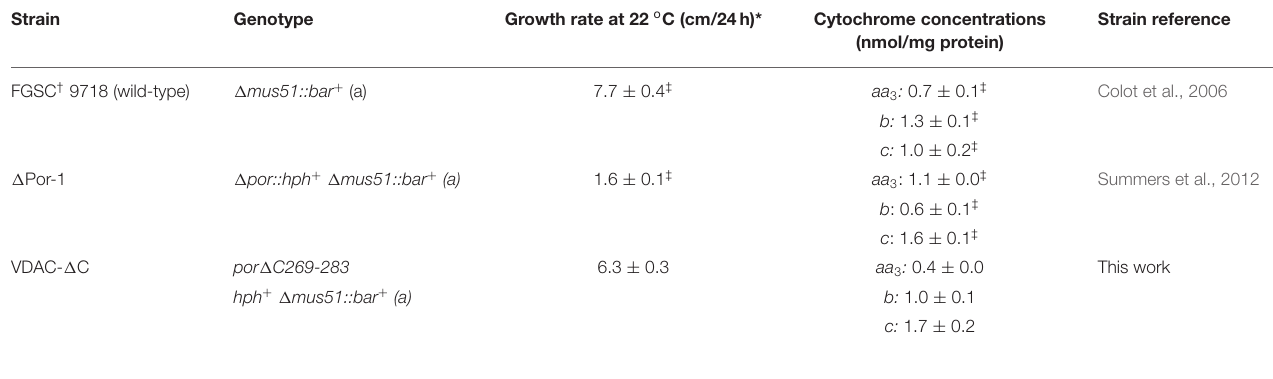
TABLE 1 | Genotypes and phenotypes of wild-types and strains expressing voltage-dependent anion-selective channel (VDAC) variants. Strain